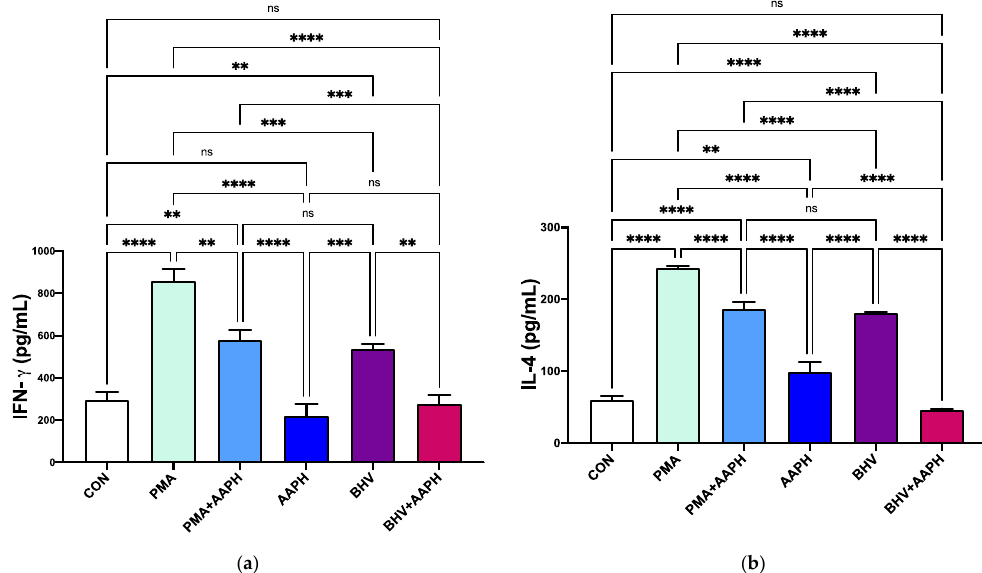
Figure 8. In vitro cytokine production of ( a ) interferon gamma (IFN- γ ) and ( b ) interleukin 4 (IL-4). Results are expressed as estimated means ± SEM. CON = Untreated peripheral mononuclear blood cells (PBMCs); PMA = PBMCs treated with 10 ng/mL phorbol 12-myristate 13-acetate (PMA) and 1 μ g/mL ionomycin; PMA + AAPH = PBMCs treated with 10 ng/mL PMA, 1 μ g/mL ionomycin, and 3 mM of 2,2 ′ -Azobis(2-amidinopropane) dihydrochloride (AAPH); AAPH = PBMCs treated with 3 mM AAPH; BHV = PBMCs treated 8 × 10 4 TCID 50 Bovine Herpesvirus 1 per 1 × 10 6 PBMCs; BHV + AAPH = PBMCs treated 8 × 10 4 TCID 50 Bovine Herpesvirus 1 per 1 × 10 6 PBMCs and 3 mM AAPH. Results were compared with Tukey’s test. ** p < 0.01, *** p < 0.001, **** p < 0.0001, ns: p >